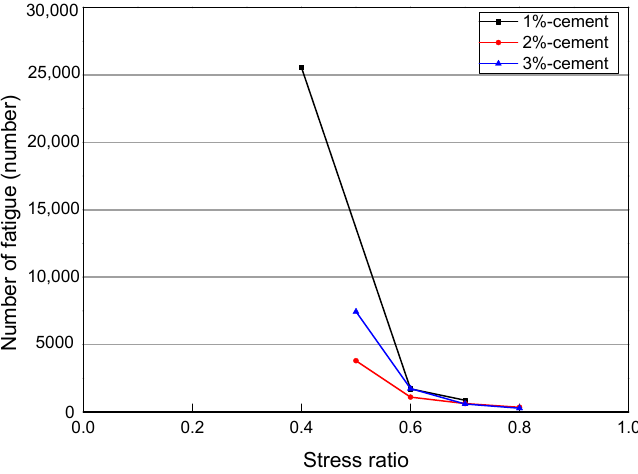
Figure 8. Fatigue times of different cement contents.